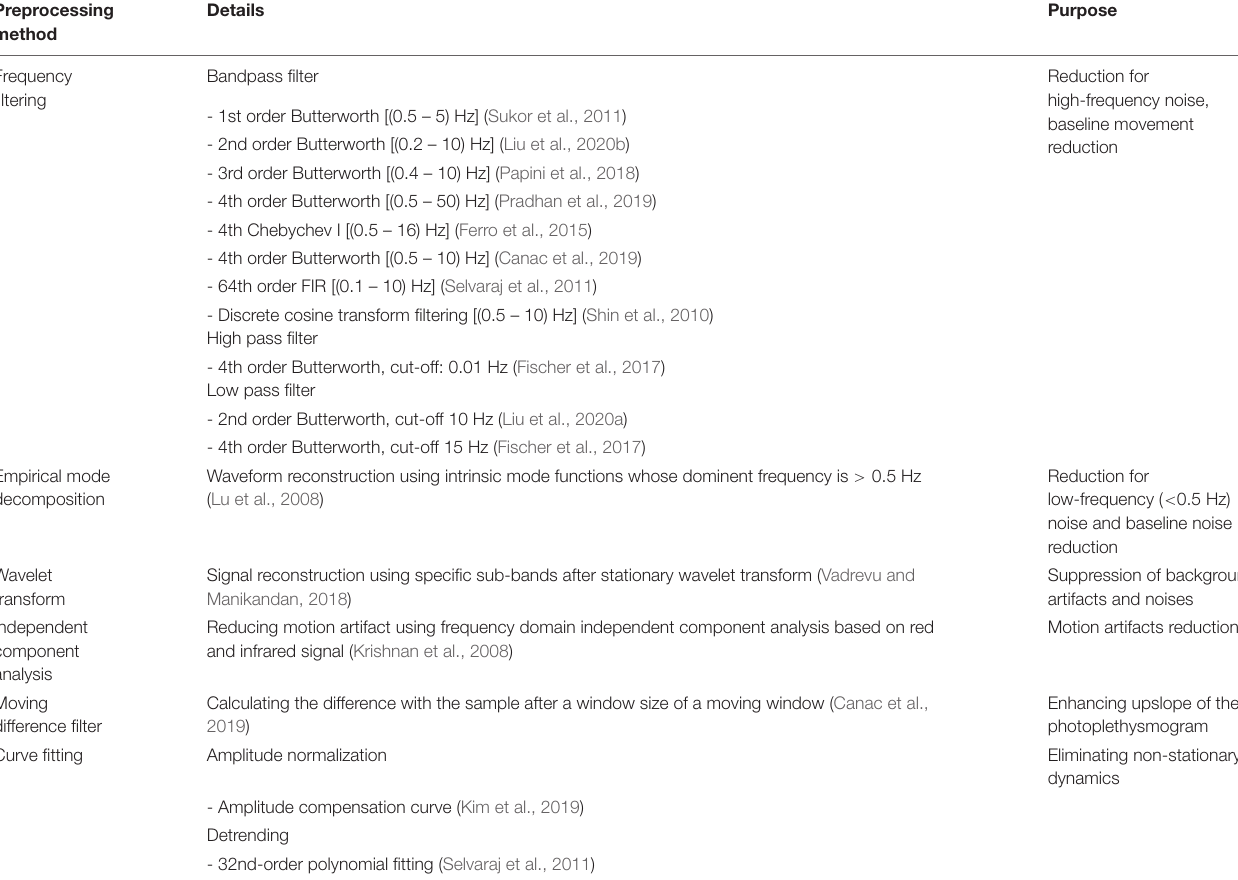
TABLE 2 | Summary of preprocessing methods for